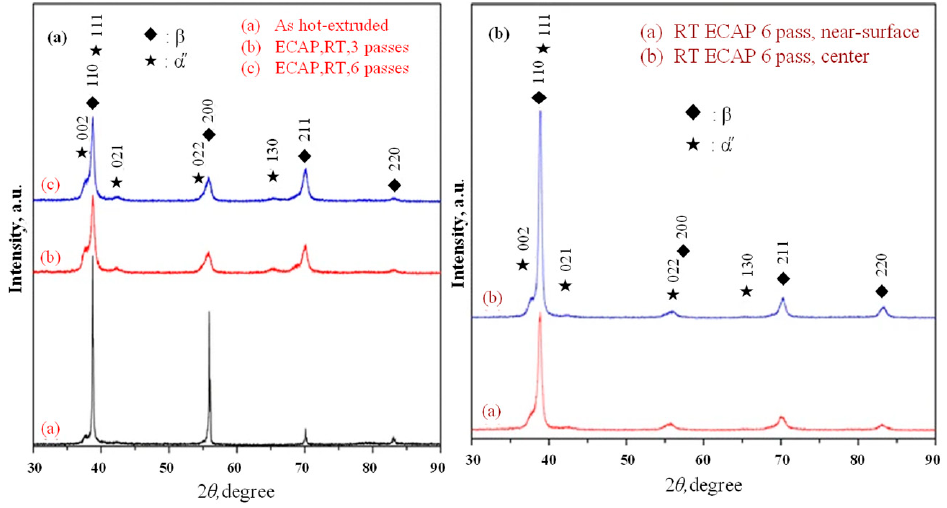
Figure 19. XRD patterns of different phases [117]: ( a ) Different processing passes; ( b ) different regions. Reproduced with permission from Springer Nature.